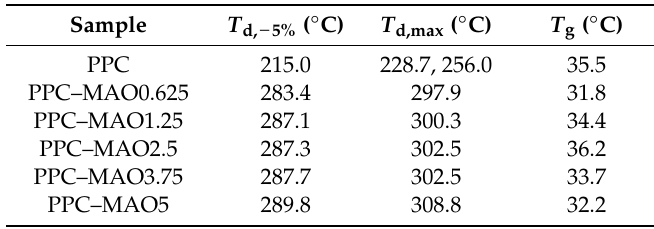
Figure 1. The Thermogravimetric analysis (TGA) curves for PPC and PPC–MAOs with networks. Table 2. The thermal properties of PPC and PPC–MAOs with networks.